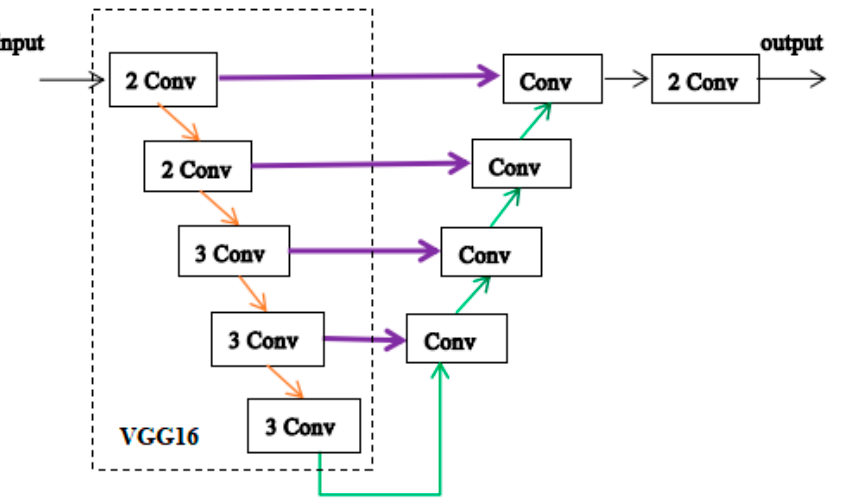
Figure 4. The network design of Generator 2. In Generator 2, a transfer learning model is imple- mented as the encoder to extract features. The decoder performs four upsampling steps, followed by a series of convolutions to produce the